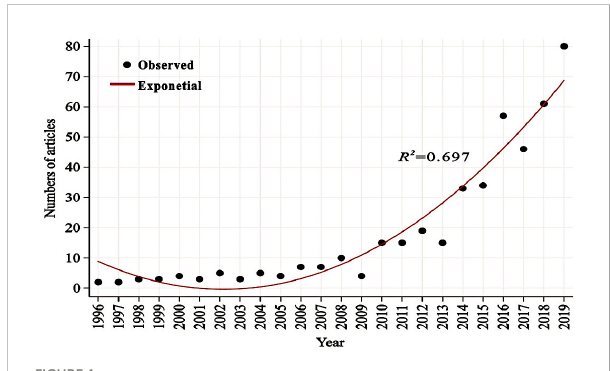
FIGURE 1 The number of articles in international cruise research published in